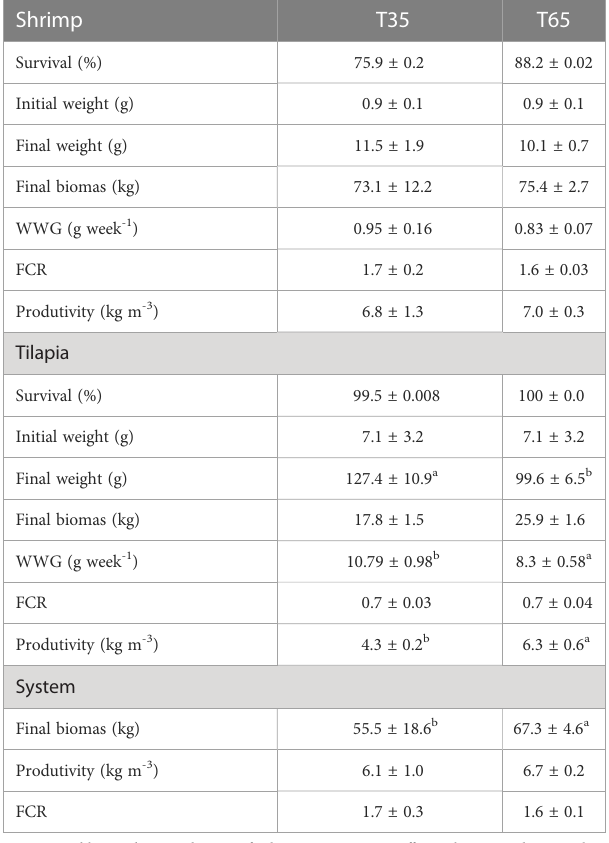
WWG, weekly weight growth; FCR, feed conversion rate. Different letters in the same line represent signi fi cant differences (p < 0.05) between